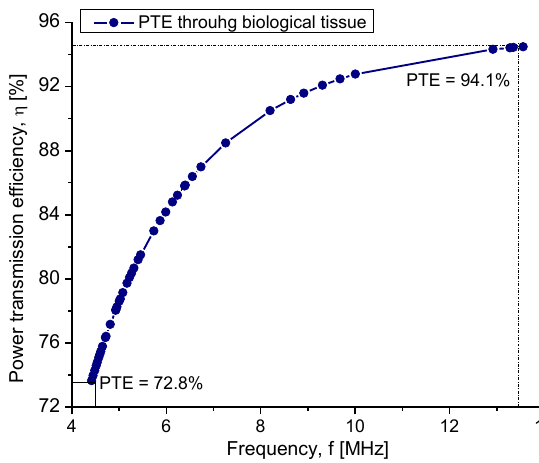
Figure 11. Power transmission efficiency according to the operating frequency system.